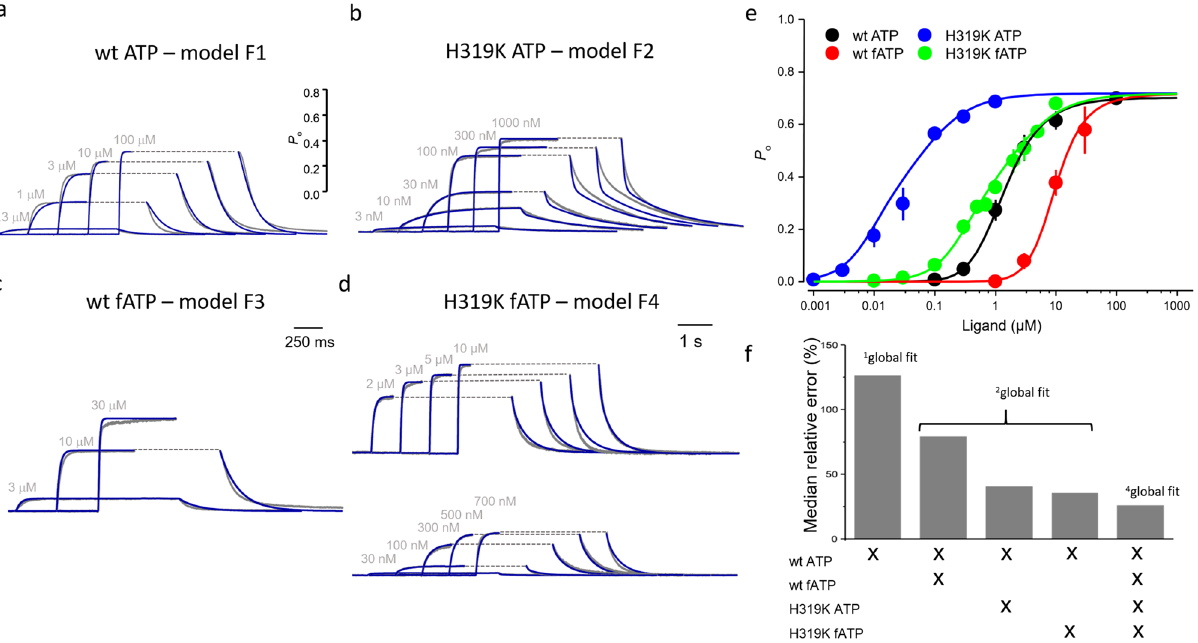
Figure 4. 4 Global fit. ( a – d ) Activation and deactivation time courses of the data (gray) wt ATP, H319K ATP, wt fATP, and H319K fATP. The respective ligand concentrations are indicated. ( e ) Equilibrium concentration- P o relationships corresponding to the concentrations in ( a – d ). The data in ( a – e ) were globally fitted ( a – d ) blue curves; ( e ) colored curves) with the models F1, F2, F3 and F4 (Fig. 3) to the data by the 4 global fit. f Median of the relative error of the parameters obtained by the indicated global fits. The 4 global fit produced the lowest median of the relative error. For further explanation see text and